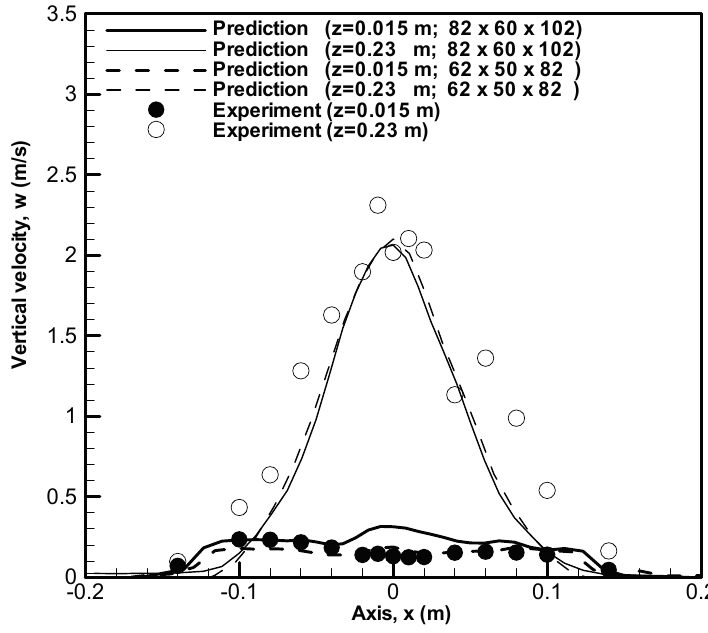
Figure 4. Profiles of the measured and predicted longitudinal velocity at z = 0.015 and 0.23 m.